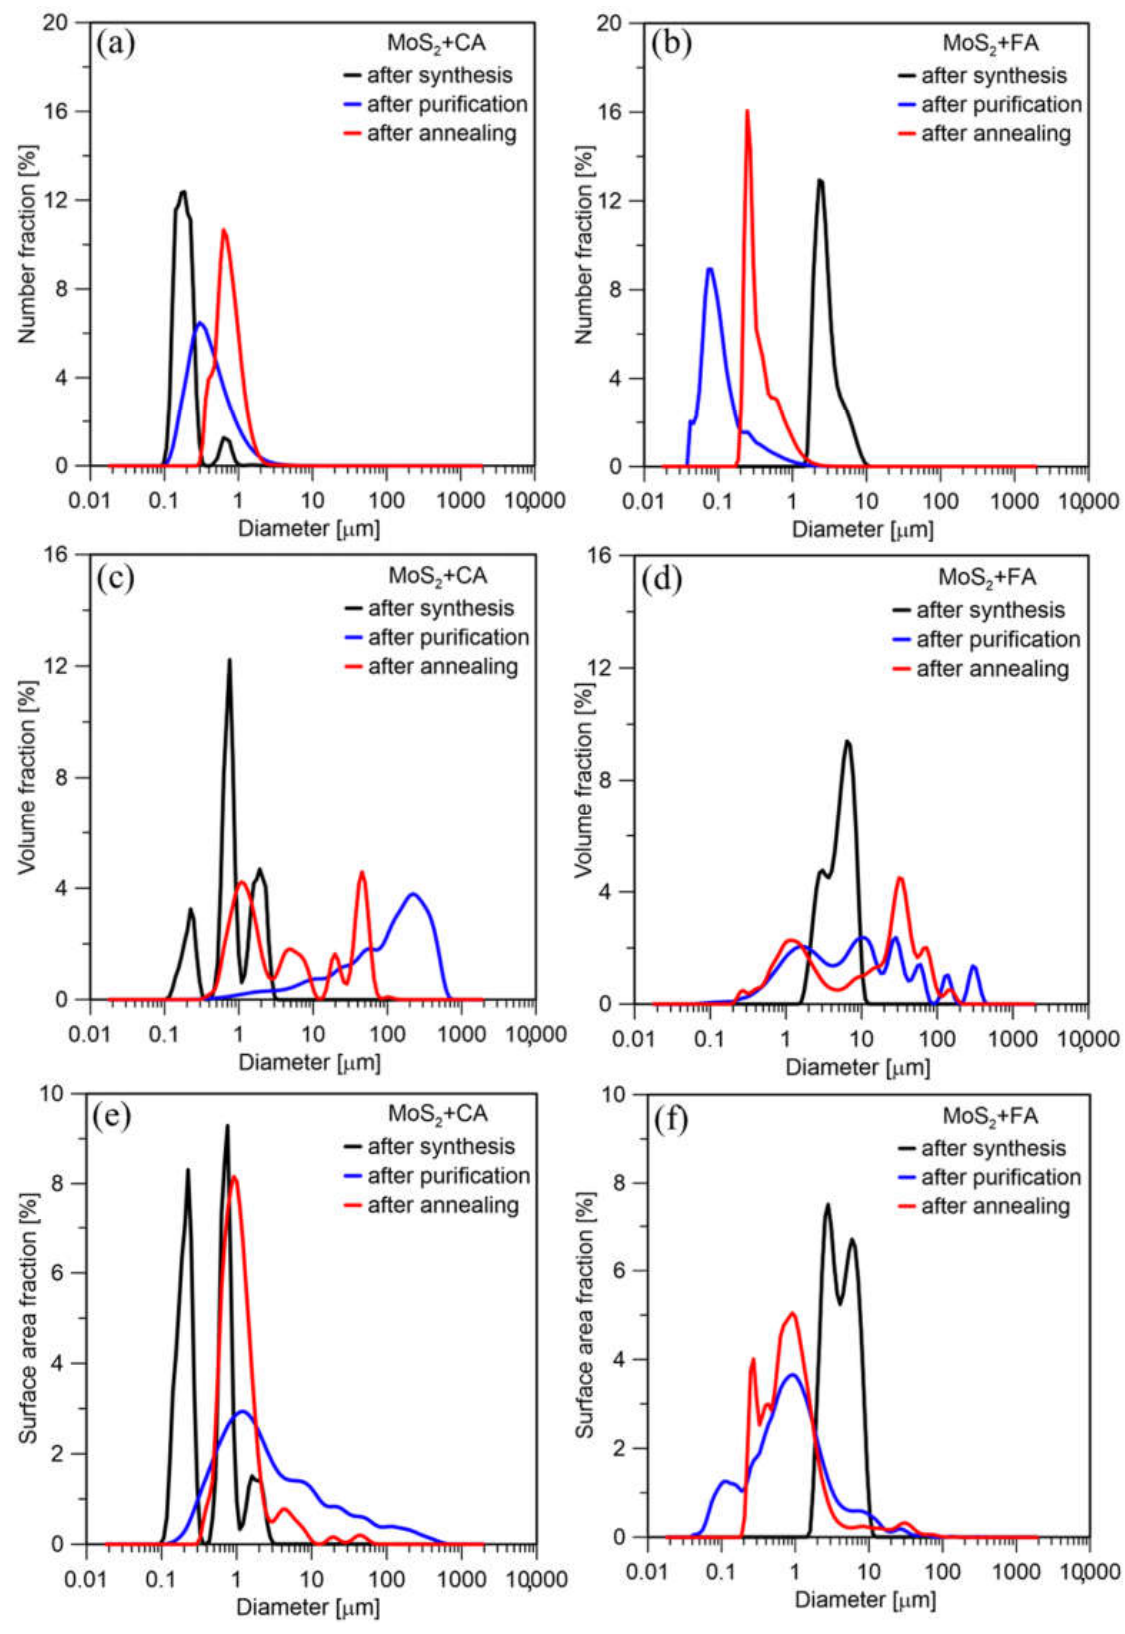
Figure 8. PSD ( a ) by number, ( c ) surface area, ( e ) volume of particles synthesized using citric acid; PSD ( b ) by number, ( d ) surface area, ( f ) volume of particles synthesized using formic acid.